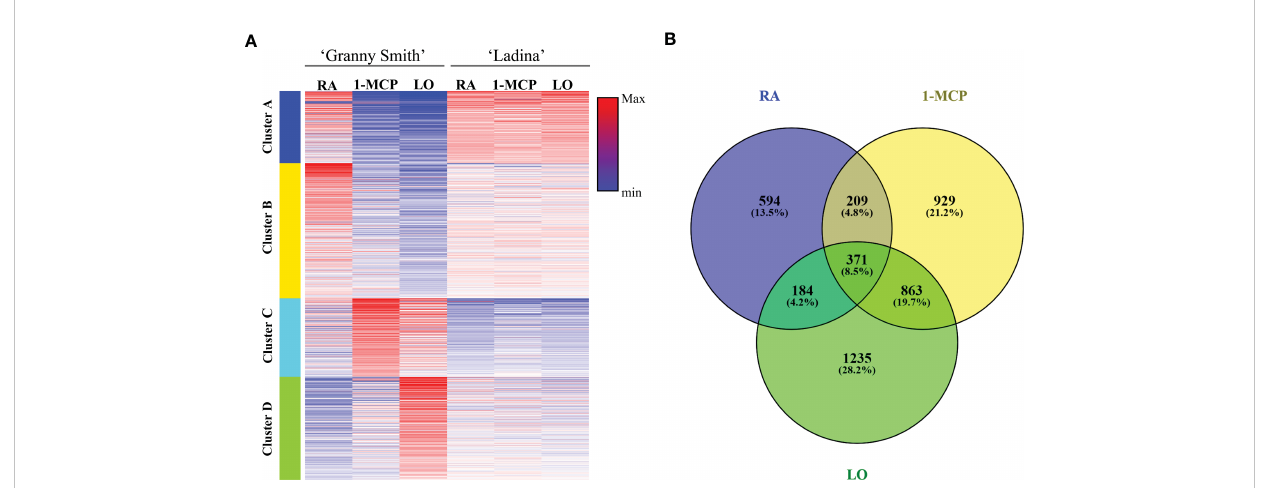
FIGURE 5 Heatmap (A) showing the expression pro fi le of DEGs in ‘ Granny Smith ’ and ‘ Ladina ’ . K-mean cluster analysis was also performed, and four different clusters were identi fi ed (Cluster A – D). RA, Regular Atmosphere; 1-MCP, Regular Atmosphere + 1-MCP treatment; LO, Low Oxygen condition. In (B) is reported the Venn diagram of the DEGs identi fi ed between the two cultivars for each storage strategies